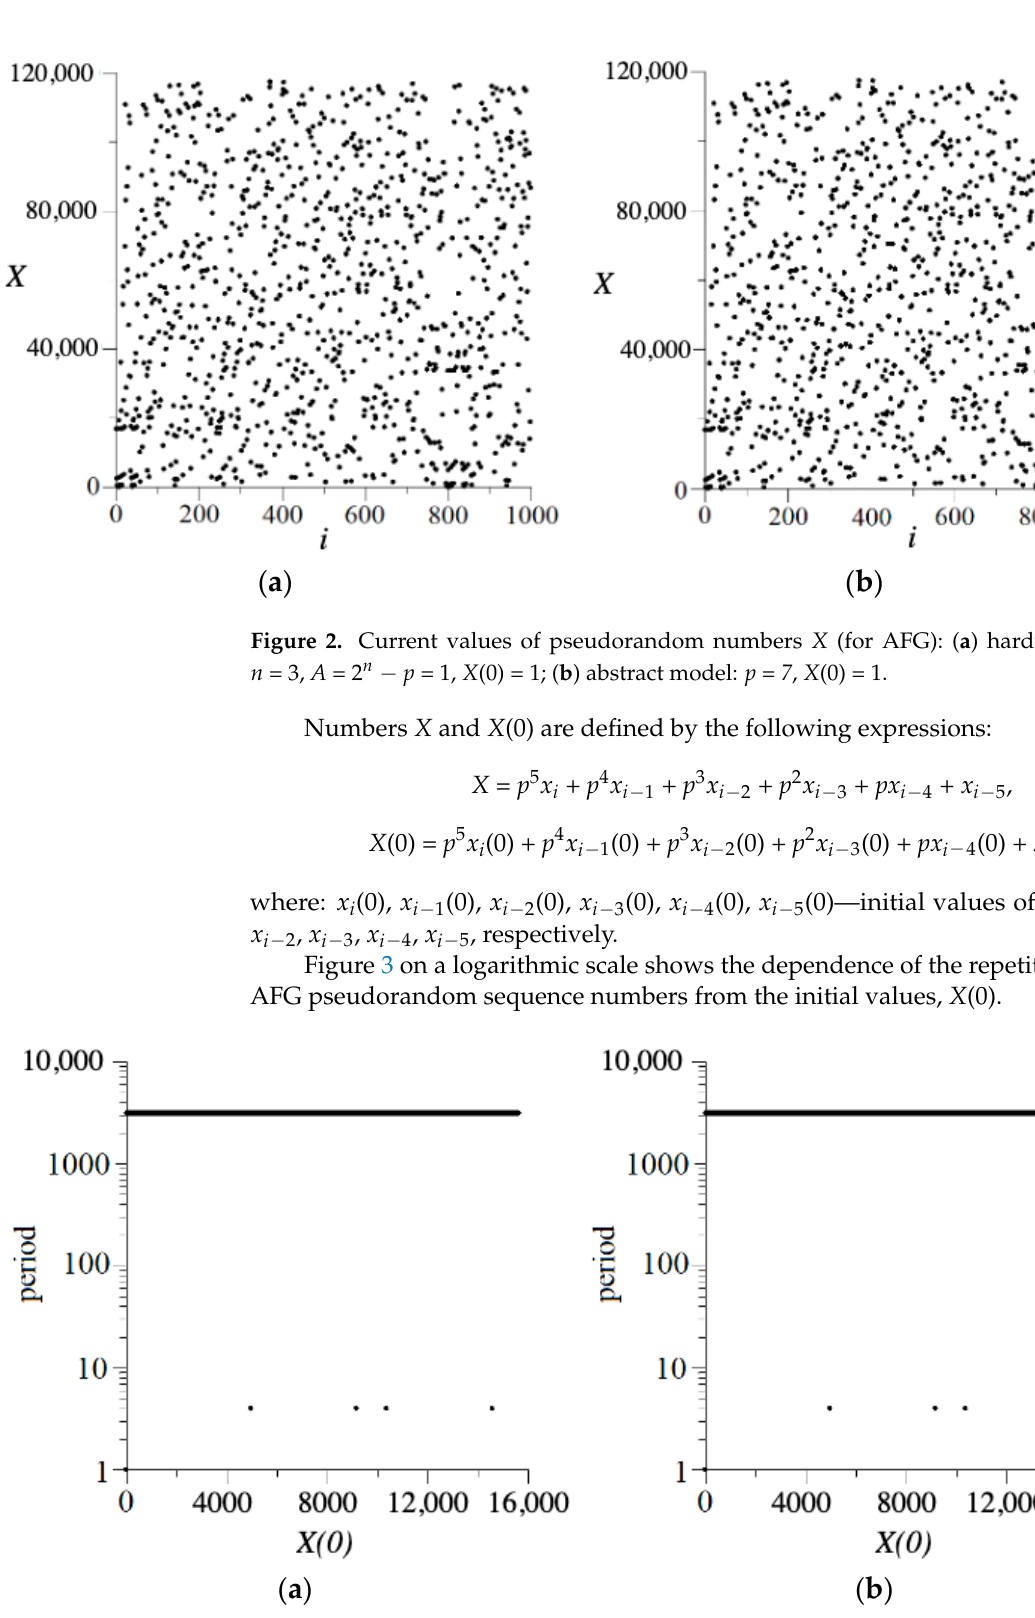
Figure 3. Dependencies of repetition periods from X (0) (for AFG): ( a ) hardware model: p = 5, n = 3, A = 2 n − p = 3, X (0) = 0 ÷ p 6 − 1; ( b ) abstract model: p = 5, X (0) = 0 ÷ p 6 − 1.